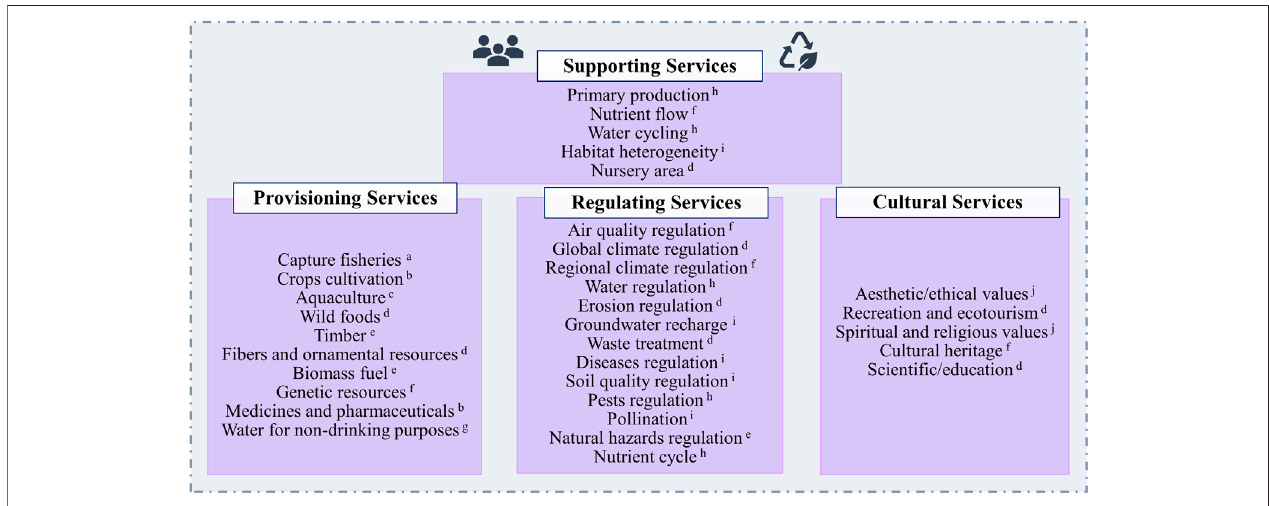
FIGURE 3 | Ecosystem Services identi fi ed in mangrove ecosystems from around the world. and represent the relationship between all ES and human well- being and biodiversity, respectively. Sources: a Conchedda et al., 2011, b Bandaranayake, 1998, c Palacios and Cantera, 2017, d Barbier et al., 2011; e Barbier, 2007; f Samoilys, et al., 2015; g Grizzetti et al., 2016; h Zedler and Kercher, 2005; i Macintosh and Ashton, 2002; j Atkinson et al.,